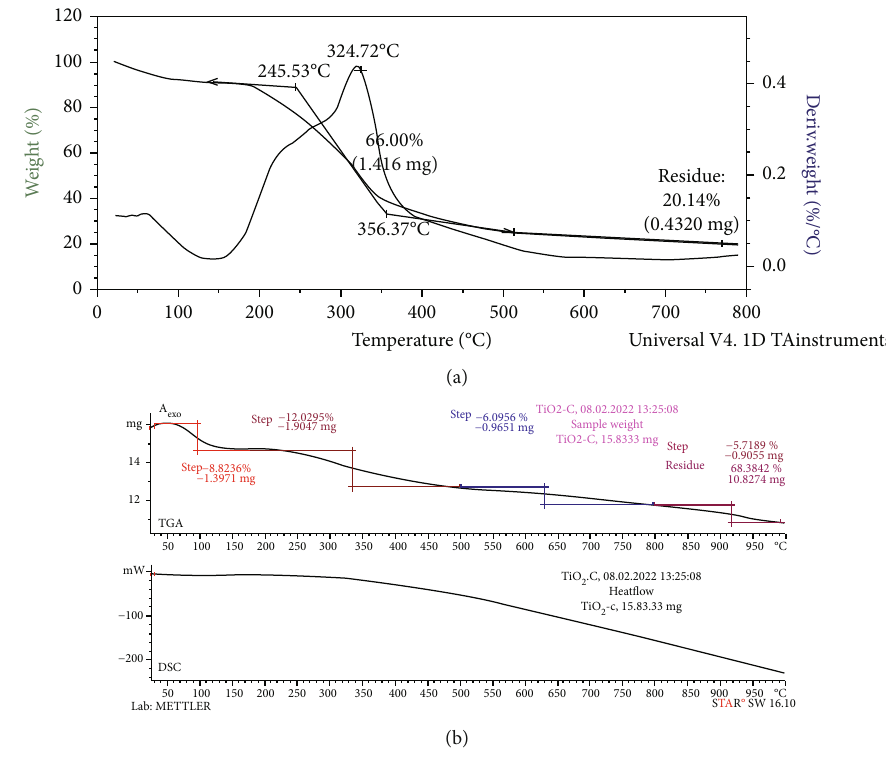
Figure 3: Thermogravimetric analysis of jackfruit peel biomass.